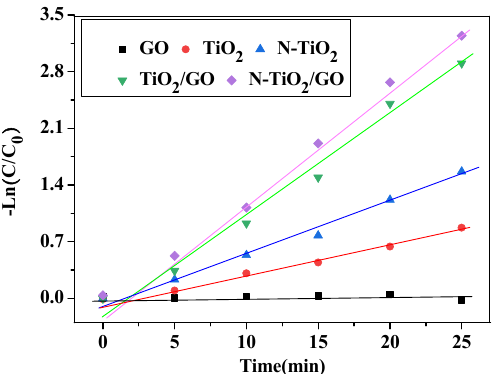
Figure 10. Dynamic simulations of the different samples for RhB photocatalysis.